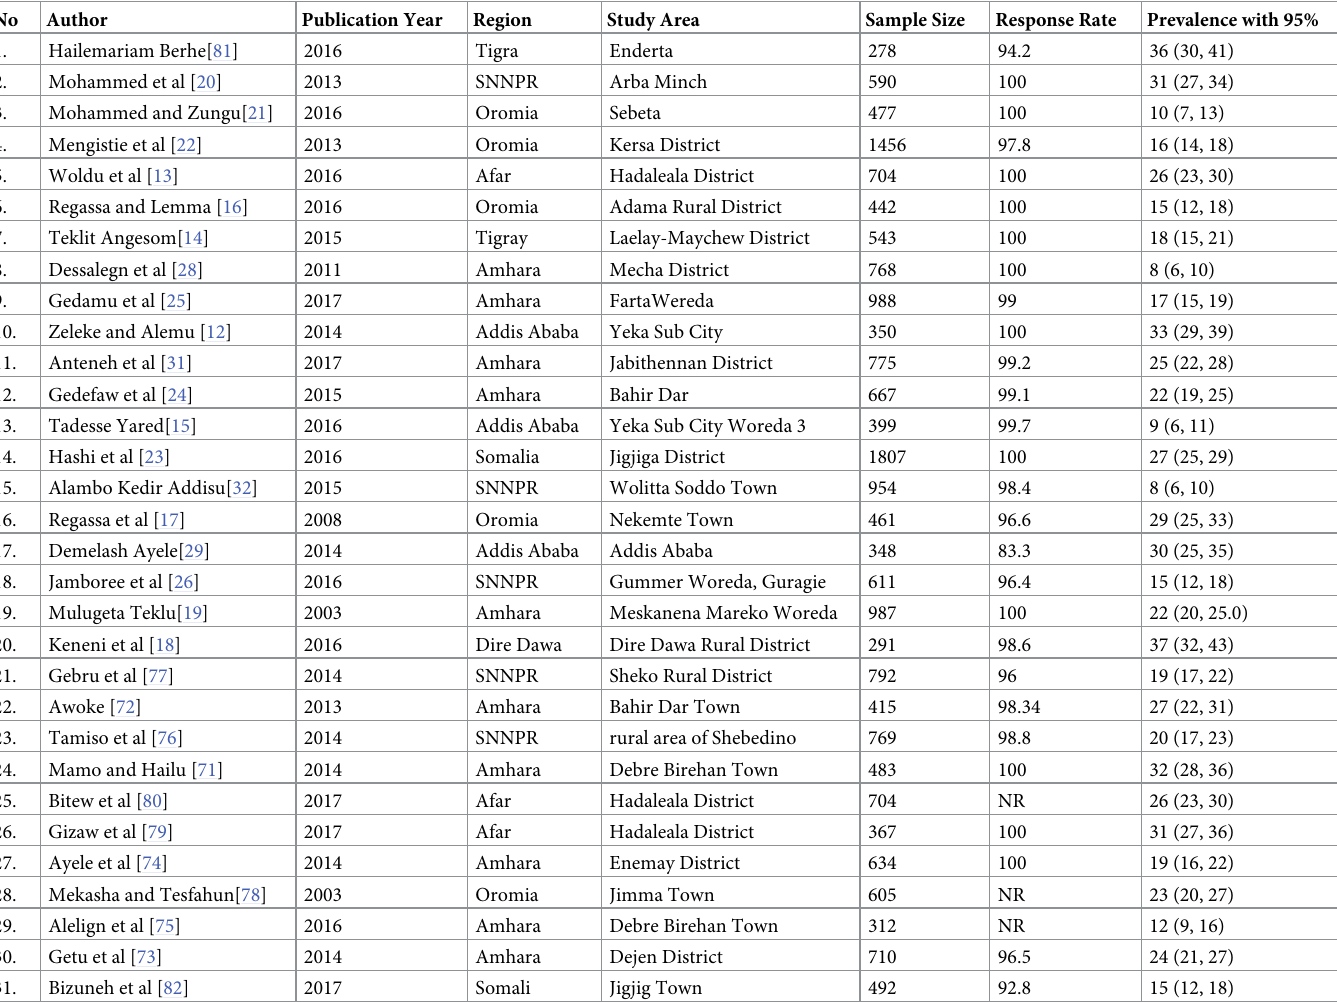
Table 2. Descriptive summary of 31 studies included in the meta-analysis of the prevalence and determinants of diarrhea among under-five children in Ethiopia